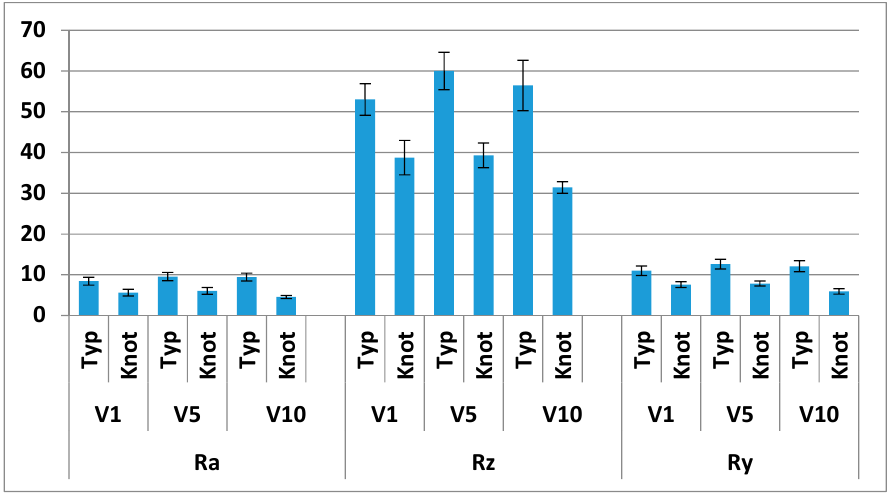
Figure 6. Surface roughness parameters Ra, Rz and Ry (µm) of oak wood veneers (V1, V5 and V10) on typical wood structure areas (Typ) and areas around dead knot (Knot).